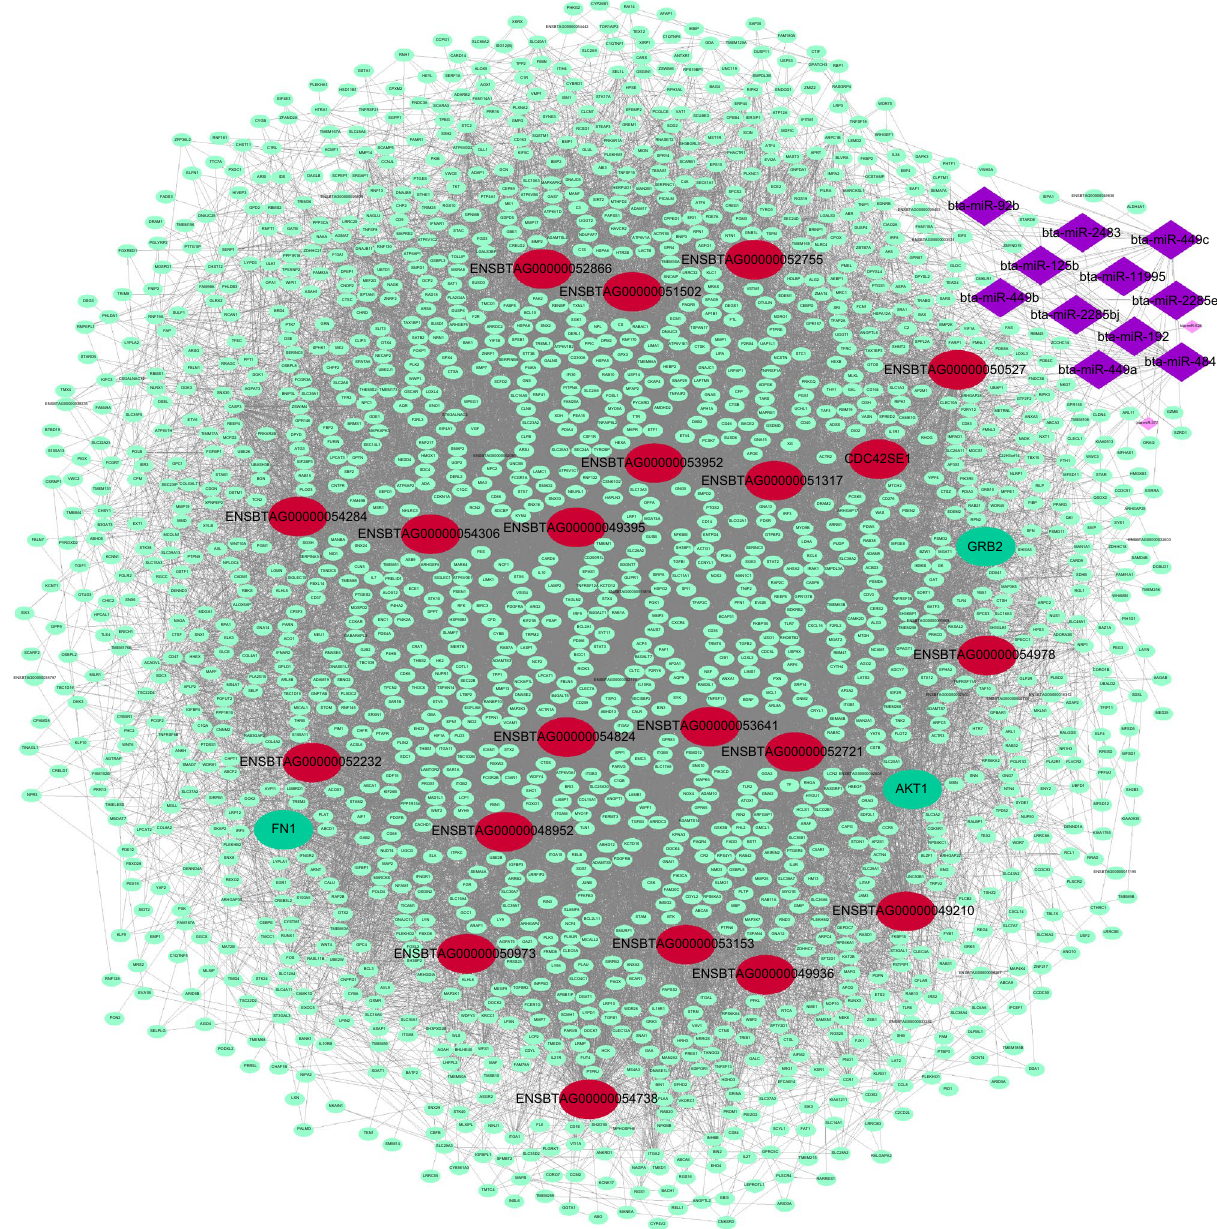
Figure 7. Integrated regulatory network of purple mb-module and turquoise Rb-module. Small light turquoise circles represent hub genes, bold large red circles represent hub-hub lncRNAs and bold large turquoise circles represent hub-hub mRNAs in turquoise Rb-module. Also, small light purple diamonds represent purple mb-module and large bold diamonds represent hub miRNAs in this module. Only the targets that have been predicted by all target prediction software are shown. Cytoscape software (version 3.7.2) (https:// cytos cape. org/) was used to generate this